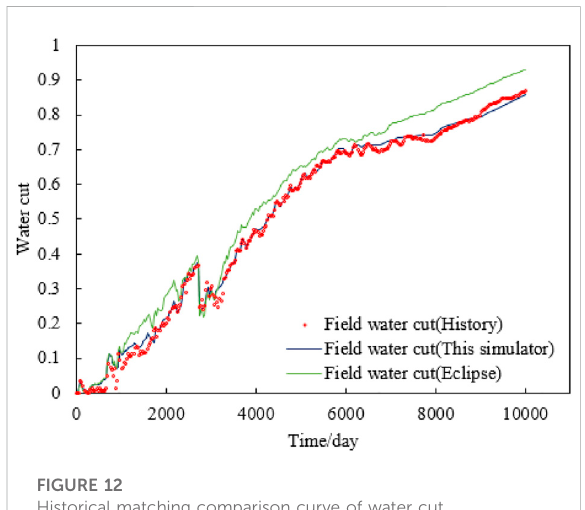
FIGURE 12 Historical matching comparison curve of water